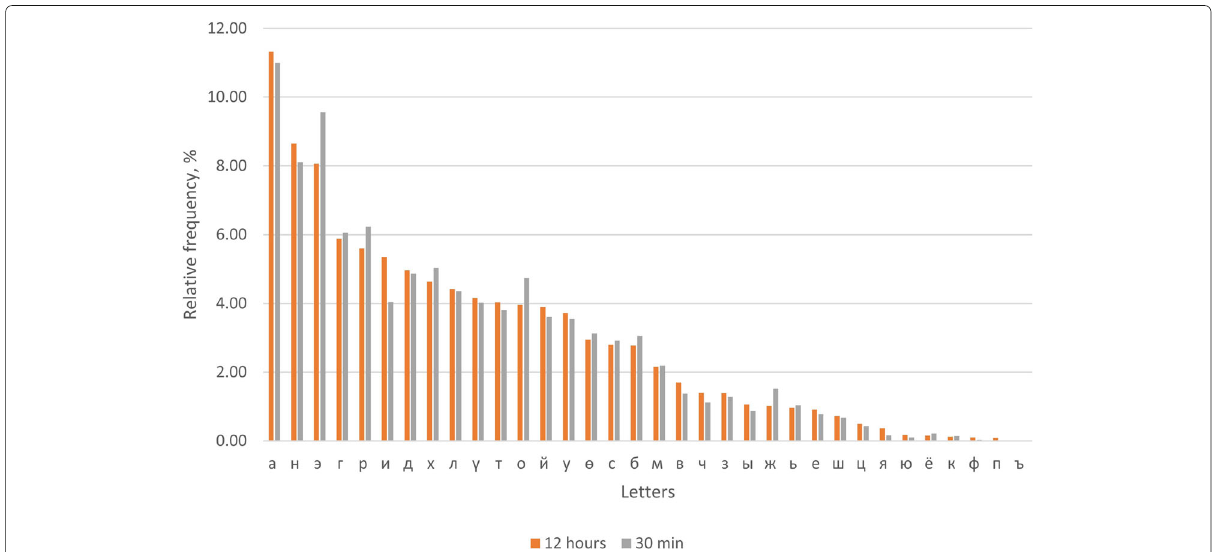
Fig. 2 Distribution of each letter in 30-min and 12-h target language datasets